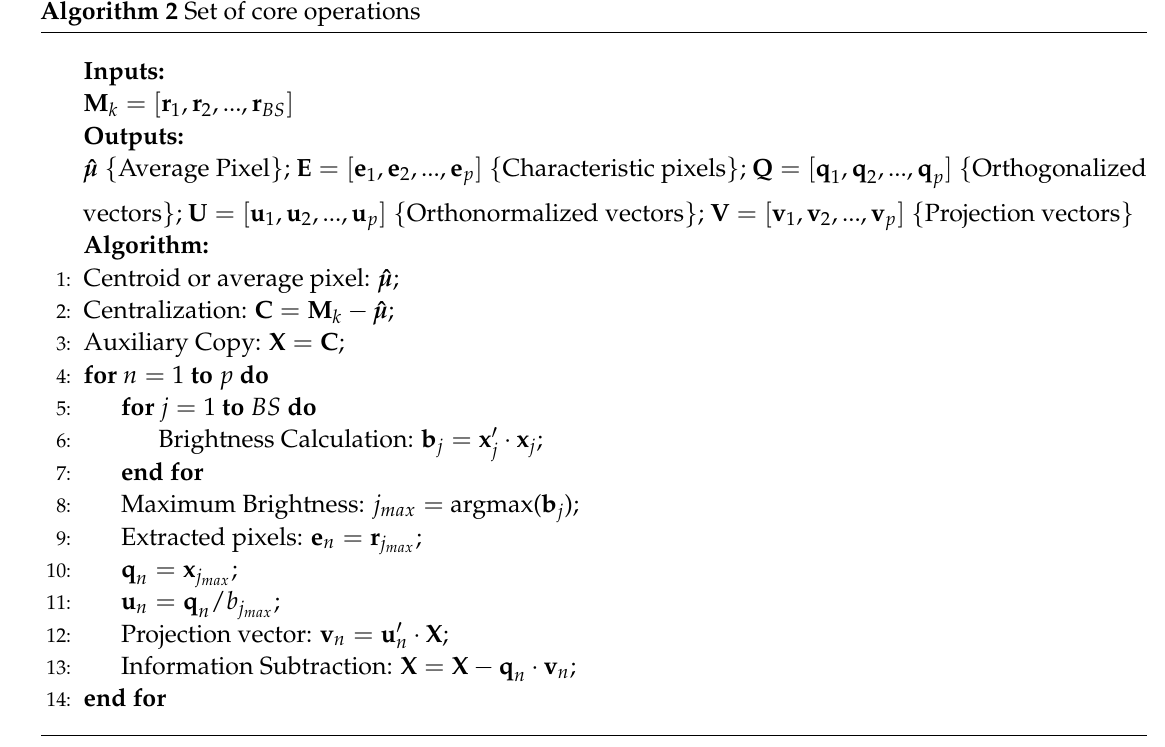
Algorithm 2 Set of core